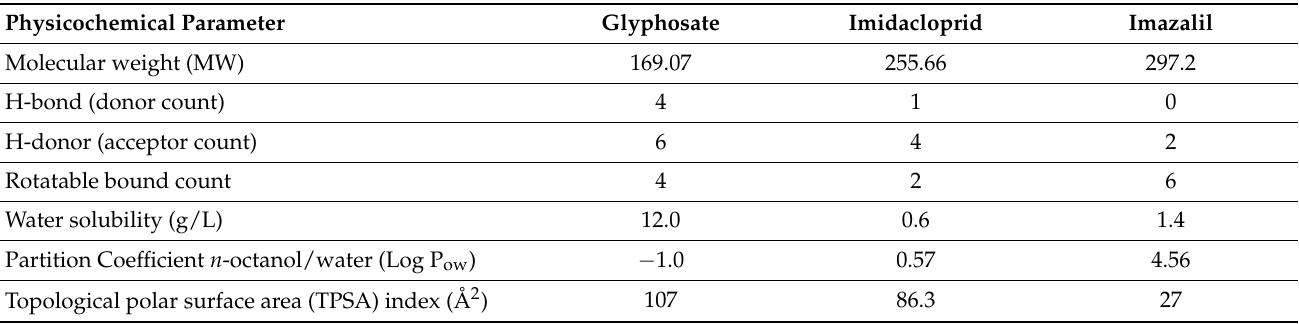
Table 3. Physicochemical properties of glyphosate, imidacloprid and imazalil considered relevant to their toxicity against Caco-2 and HepG2 cells. Data were obtained from Pubchem and INCHEM (IPCS, World Health Organization)